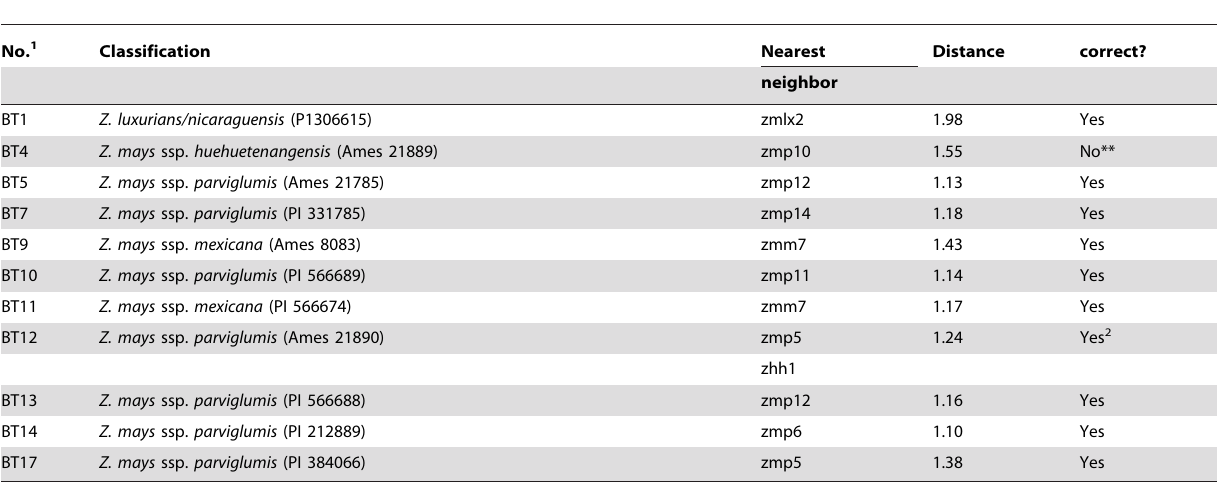
Table 1. Nearest neighbor assignment of blind test (BT) phytolith assemblages.